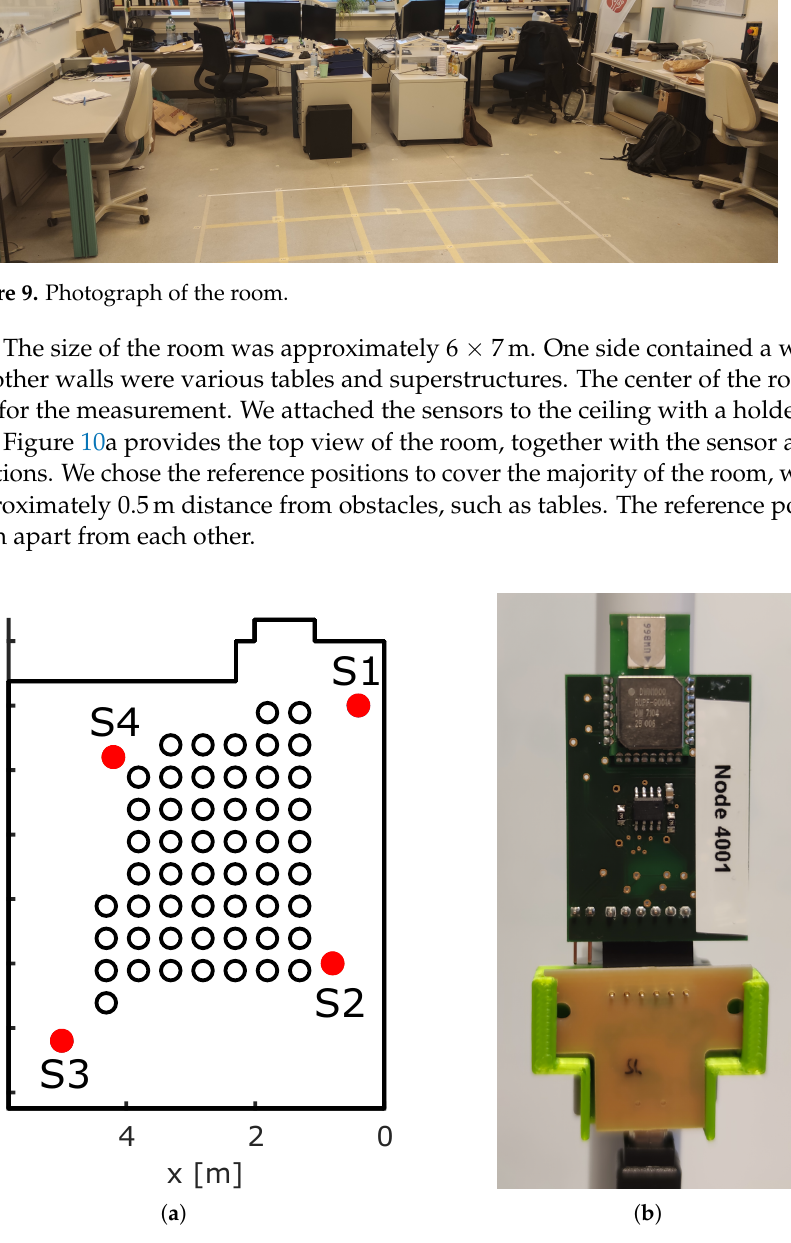
Figure 10. Theoretical MPCs calculated by raytracing. ( a ) Room with reference positions. ( b ) Sensor node plattform